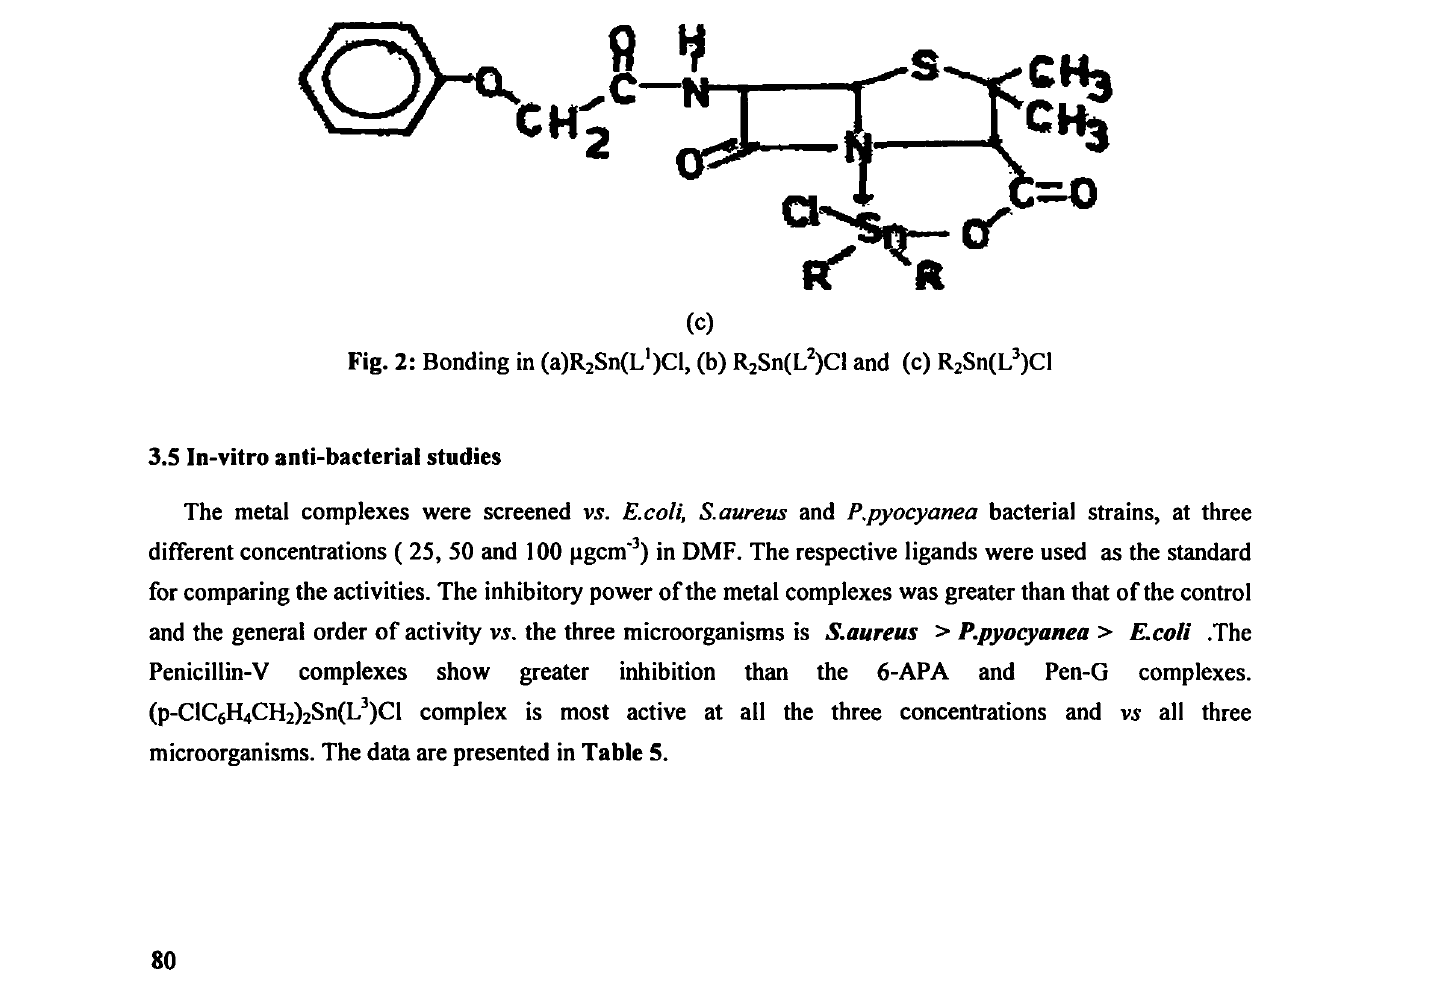
Fig. 2: Bonding in (a)R